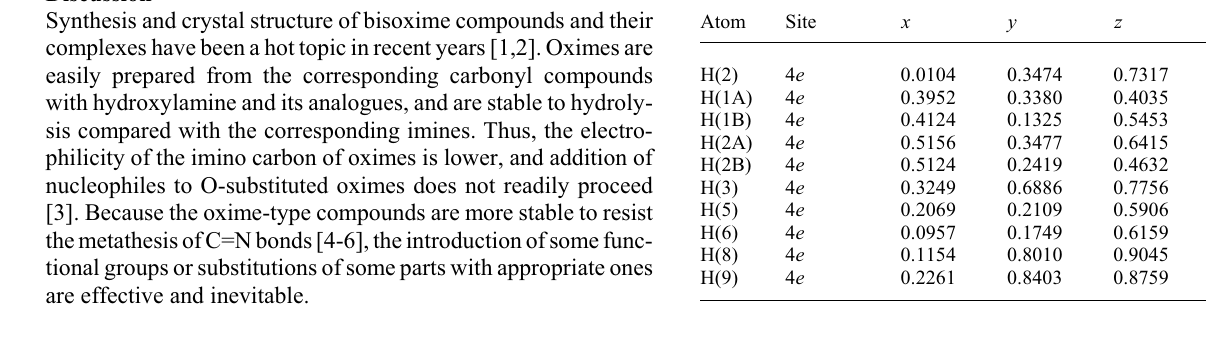
Table 3. Atomic coordinates and displacement parameters (in Å 2